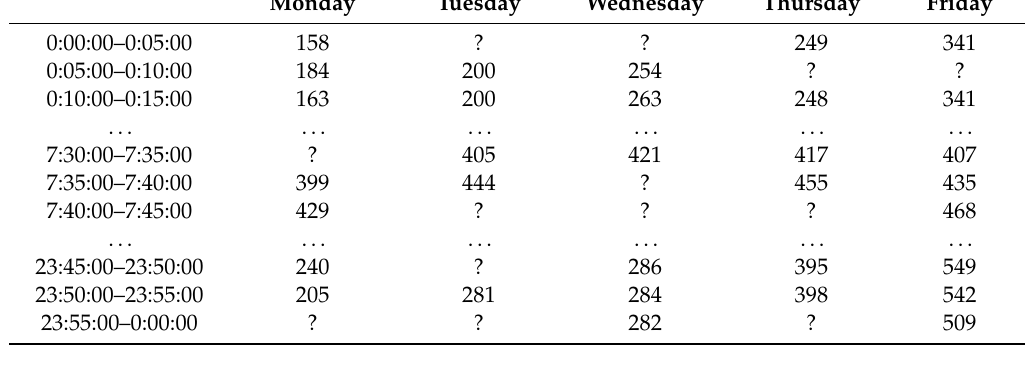
Table 2. Taxi demand volume on weekdays. The “question marks” in Table 2 represent the missing values.